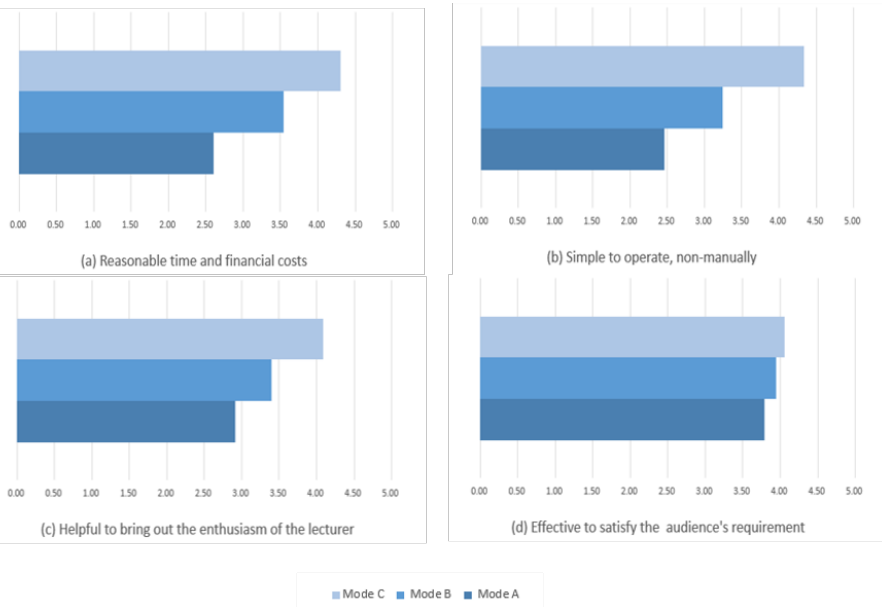
Figure 8. Survey on the three modes for recording online course videos.